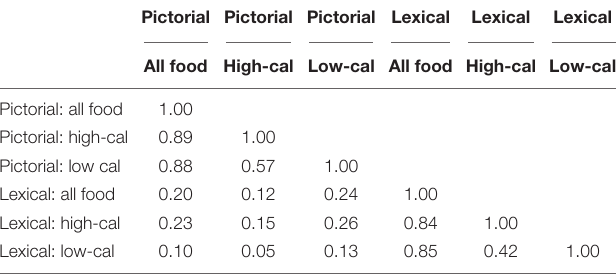
TABLE 3 | Correlations between the lexical and pictorial task attentional bias scores, both measured in session 1. Pictorial Pictorial Pictorial Lexical Lexical